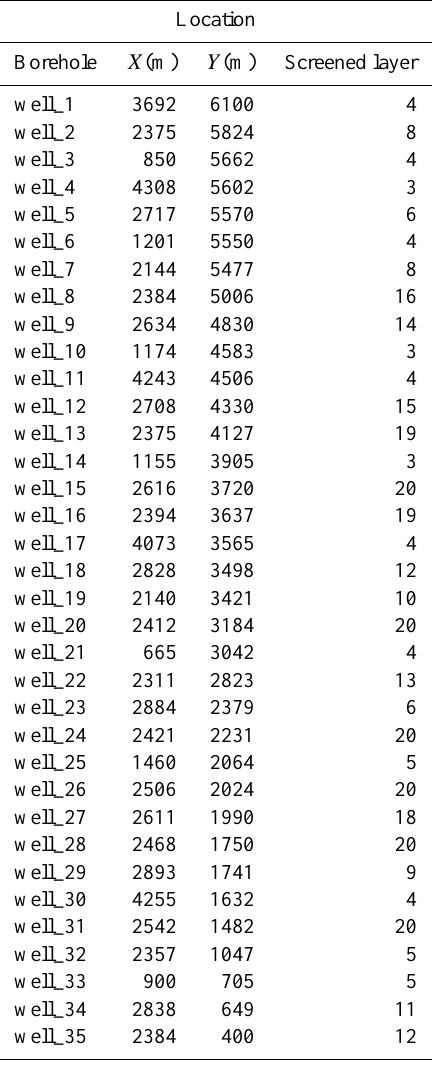
Table 2. Location and screened layer of boreholes with head mea- surements for model